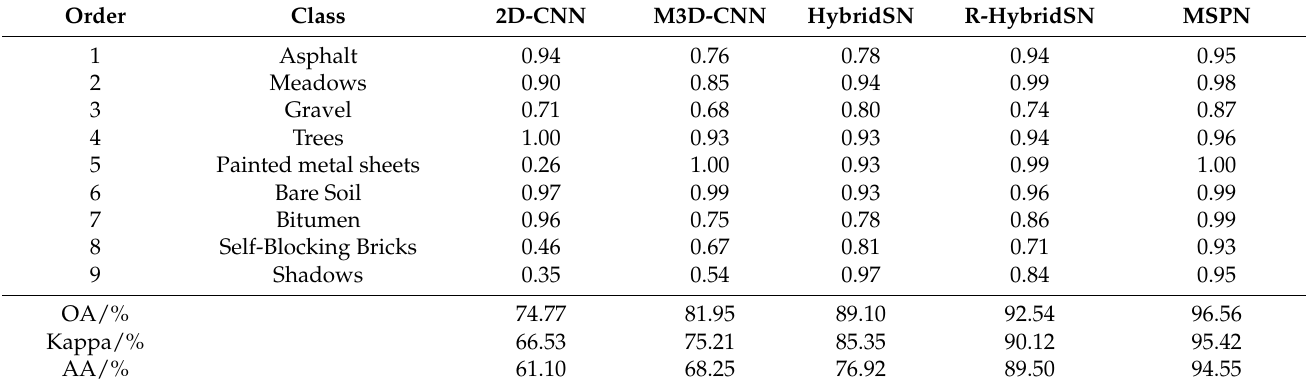
Table 4. Accuracy comparison of different methods for 0.5% samples of Pavia